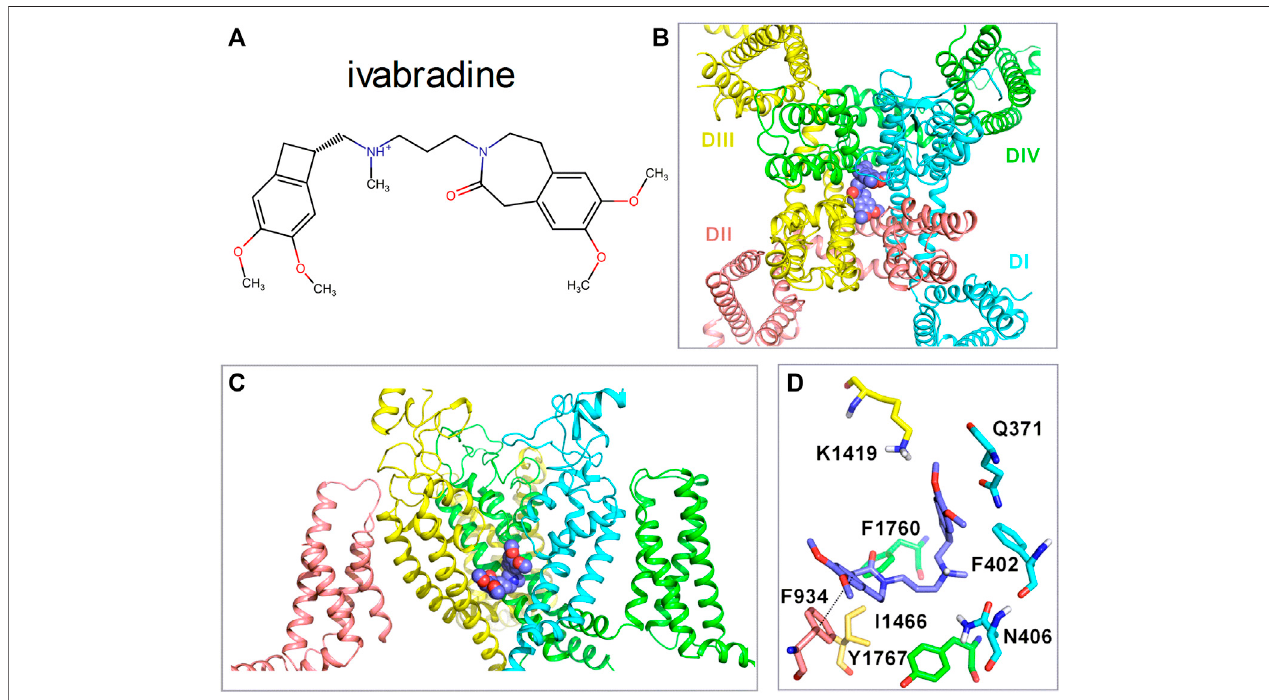
FIGURE 9 | Molecular interactions of ivabradine with Na v 1.5. (A) Chemical structure of ivabradine as used for the drug docking with a charged amine nitrogen at physiological pH. (B) Representative docking pose of Ivabradine shown as purple spheres in the cavity of Na v 1.5 (cartoon representation) viewed from the top. (C) Side view of the binding site below the selectivity fi lter, with the voltage sensor of domain II hidden for clarity. (D) Residues within 5 Å of ivabradine are shown in stick representation. Dotted lines between F934 and Ivabradine denote π - π interactions. The distance between the two benzene rings is 4.1 Å.